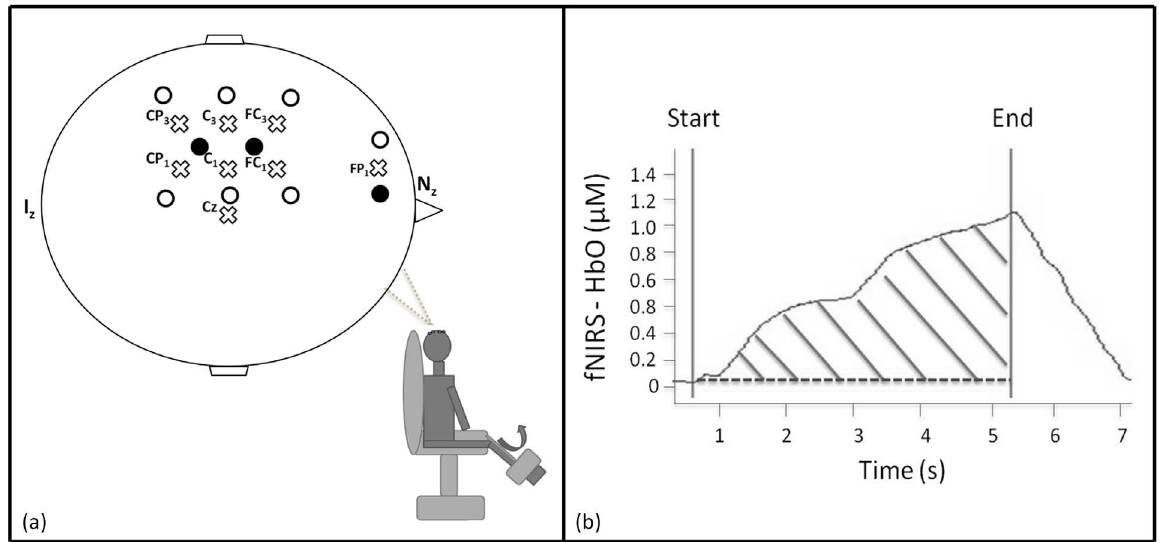
Figure 2. Measurement of cortical activity by functional near-infrared spectroscopy (fNIRS). a) fNIRS optode placement. Three receivers (black circles) and seven emitters (white circles) were set over the scalp, resulting in 9 measured channels. The crosses represent the reference points used to target primary sensory (CP 3 - CP 1 ), primary motor (C 3 - C 1 ), premotor (FC 1 - FC 3 ) and prefrontal cortical areas (FP 1 ) according to the modified international EEG 10-10 system. I z : Inion, N z : Nasion.b) Example of a functional near-infrared spectrospcopy oxyhemoglobin signal (fNIRS-HbO) during a maximal voluntary contraction in one subject. Hatched area represents the area under the curve of HbO (as index of neural activity).